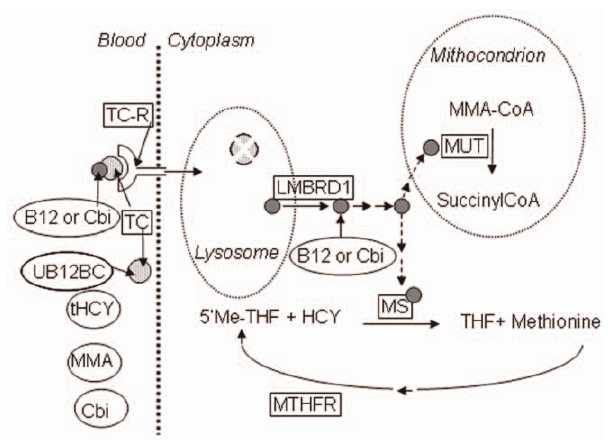
Figure 1. Simplified overview of B12 metabolism. A simplified overview of vitamin B12 (B12) metabolism in mice with focus on the analysed parameters. Through binding to the transcobalamin receptor (TC–R), the TC–B12/cobinamide(Cbi) complex is internalised into the lysosomes. TC is degraded and B12 is transported into the cytoplasm by the lysosomal membrane transporter 1 (LMBRD1). Intracellular, B12 serves as cofactor for the mitochondrial methylmalonylCoA mutase (MUT) and the cytosolic methionine synthase (MS) that acts in coordination with methylenetetrahydrofolate reductase (MTHFR). In plasma, TC circulates partly unsaturated with B12 (UB12BC). If the B12 supply to the cell is insufficient, methylmalonic acid (MMA) and homocysteine (tHcy) accumulates in the blood. The transcript level of the boxed components were analysed by quantitative reverse– transcript (q–rt–) PCR and the circularised components were analysed biochemically in either tissue or blood (plasma) as indicated.